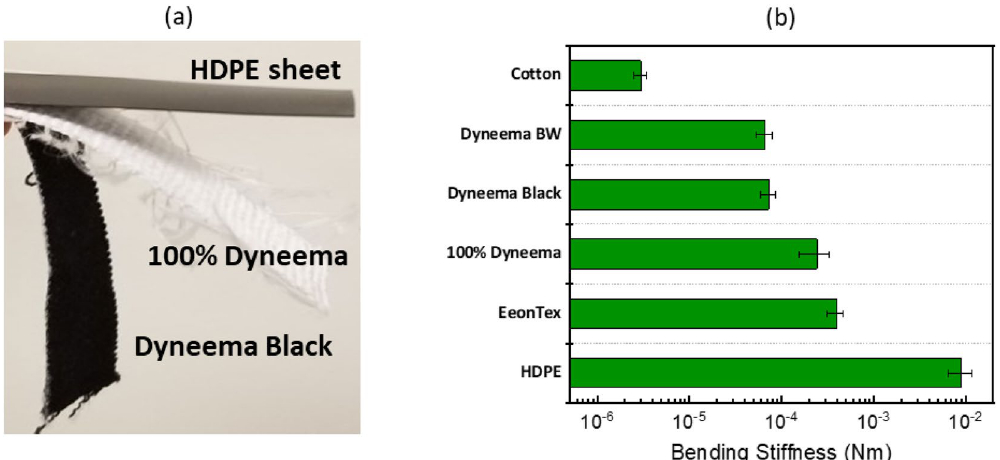
Figure 5. ( a ) Photograph of three different fabrics bending under their own weight. The stiff HDPE sheet does not visibly bend under its own weight, the Dyneema Black fabric is much more flexible as seen from its extent of bending, and the 100% Dyneema lies in between. ( b ) Measured average bending stiffness (flexural rigidity) based on the described bend testing metrology.